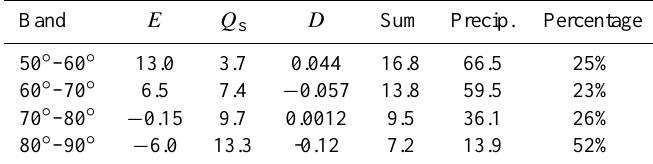
Table 3. Seasonal average surface sublimation ( E) , blowing snow sublimation ( Q s ) , divergence of blowing snow transport ( D ), and pre- cipitation amount over latitudinal bands in units of mm SWE. Sum denotes the sum of surface sublimation, blowing snow sublimation and divergence of transport, and Percentage is defined as the ratio of Sum to the total solid precipitation (Precip.). Band E Q s D Sum Precip.